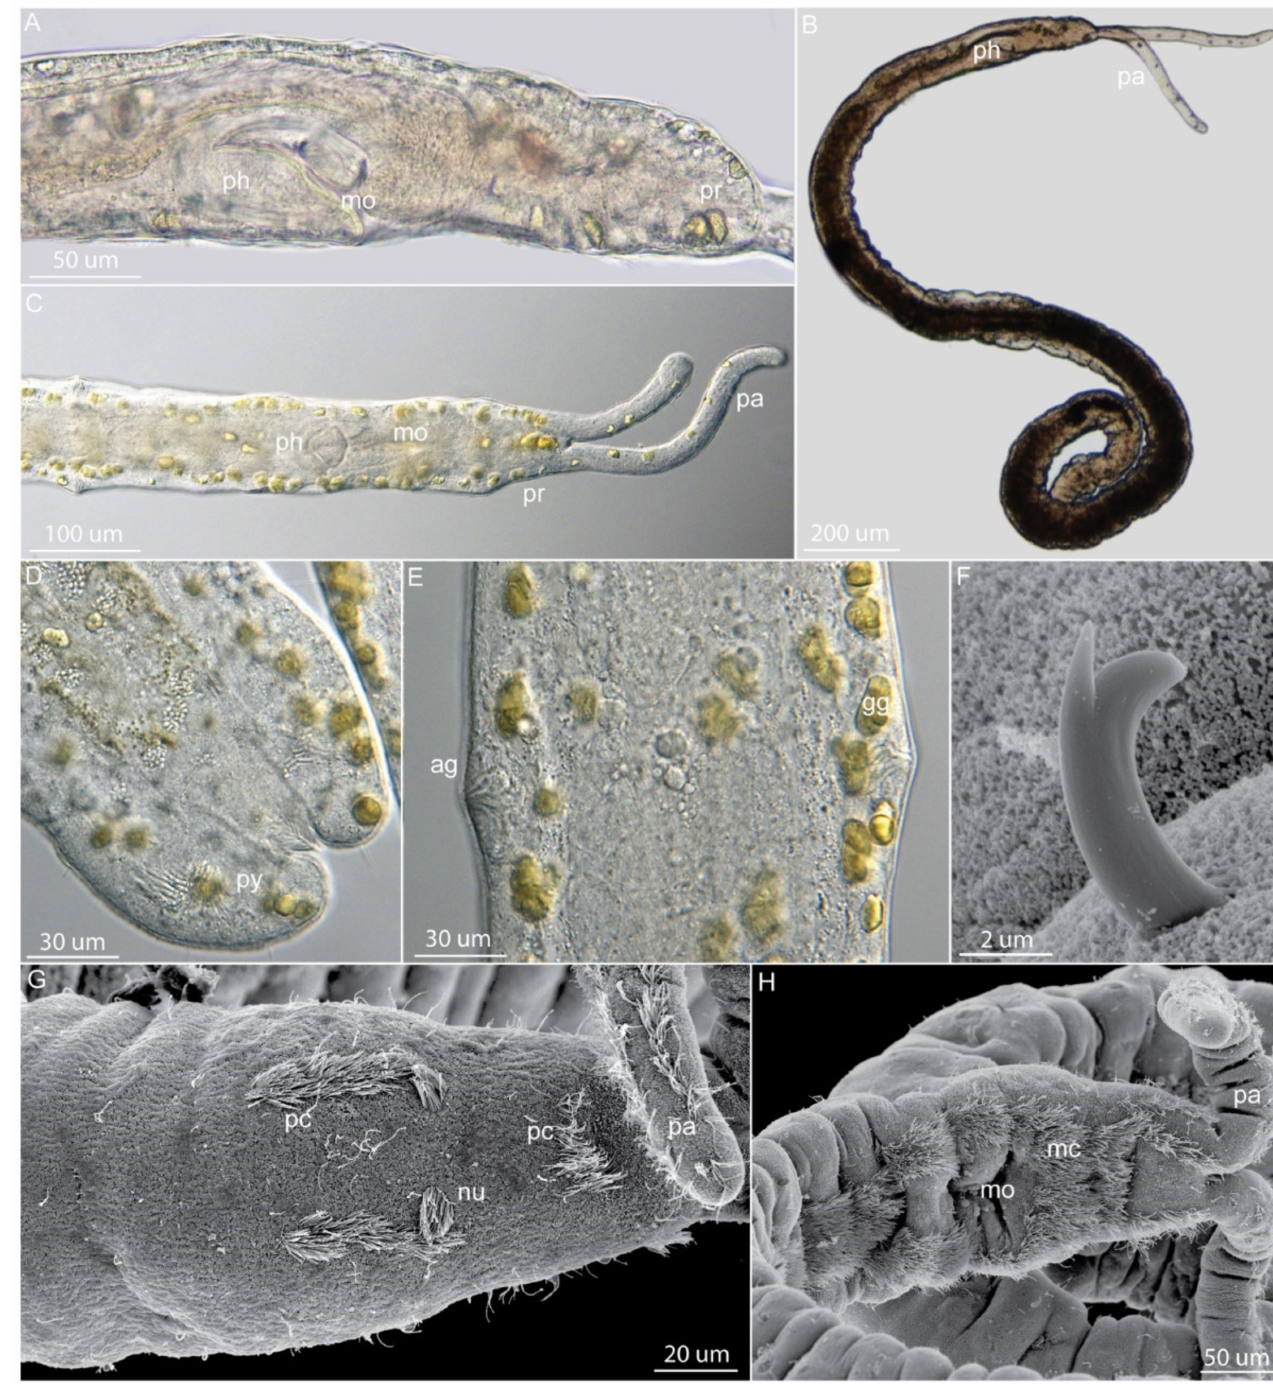
Figure 12. Morphology of Protodriloididae. ( A – E ) Protodriloides symbioticus (Roscoff, France), light micrographs. ( F – H ) Protodriloides chaetifer (Flakkerhuk, Greenland), scanning electron micrographs. ( A ) Lateral view of the anterior end. ( B ) Lateral overview of the body. ( C ) Dorsal view of the anterior end. ( D ) Dorsal view of the pygidium. ( E ) Dorsal view of a trunk segment. ( F ) Detail of the chaeta. ( G ) Dorsal view of the head. ( H ) Ventral view of the head. Abbreviations: ag, adhesive glands, gg green glands, mc mouth ciliation, mo mouth, nu nuchal organs, pa palp, pc prostomial ciliation, ph pharynx, pr prostomium, py pygidium. Reproduced with permission from